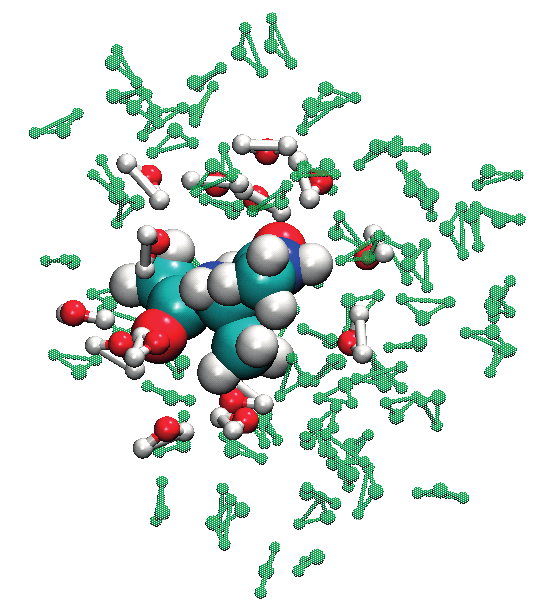
Figure 7. Alanine dipeptide solvated in water. The atoms comprising the QM region (alanine-dipeptide and first-contact shell water molecules within R inner ≤ 3.0 Å) are shown as VDW spheres and red-and-white ball-and-stick models, respectively, while MM waters are shown as green ball-and-stick